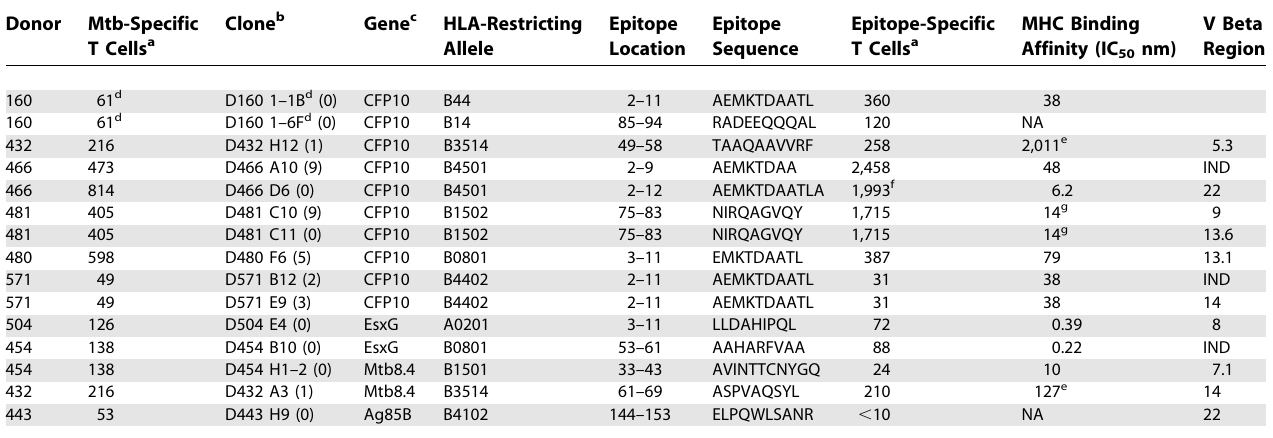
Table 3. Summary of CD8 þ T Cell Epitopes